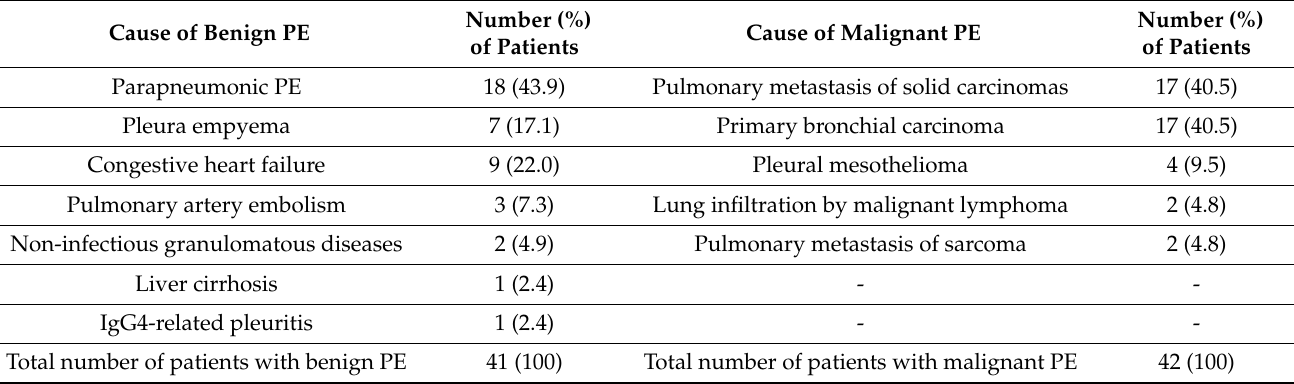
Table 1. Causes of PEs in n = 83